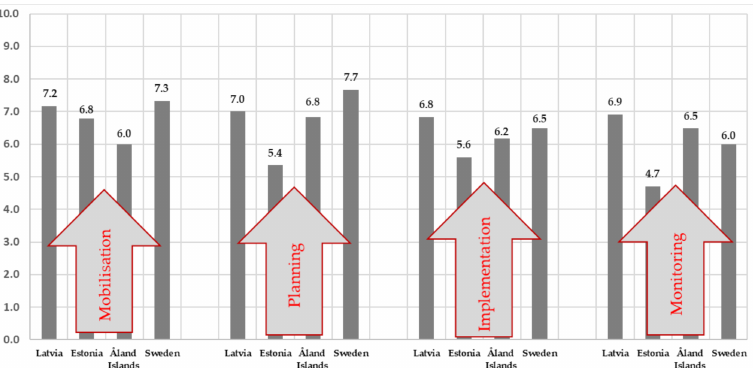
Figure 2. The summary of survey significance indicators (formal and informal spatial planning